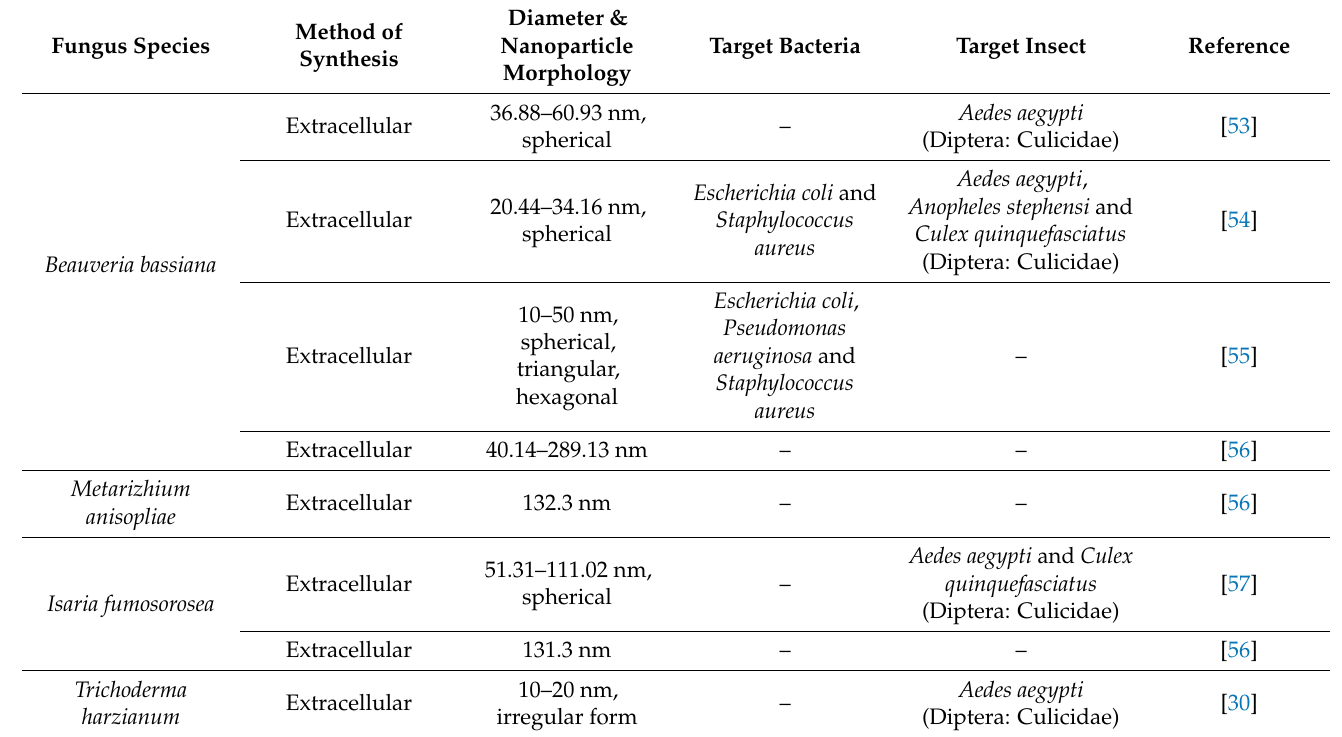
Table 1. Records of the use of entomopathogenic fungi in the biosynthesis of silver nanoparticles, with the method of synthesis used, diameter and morphology of the nanoparticles formed, and bacteria and target insects.